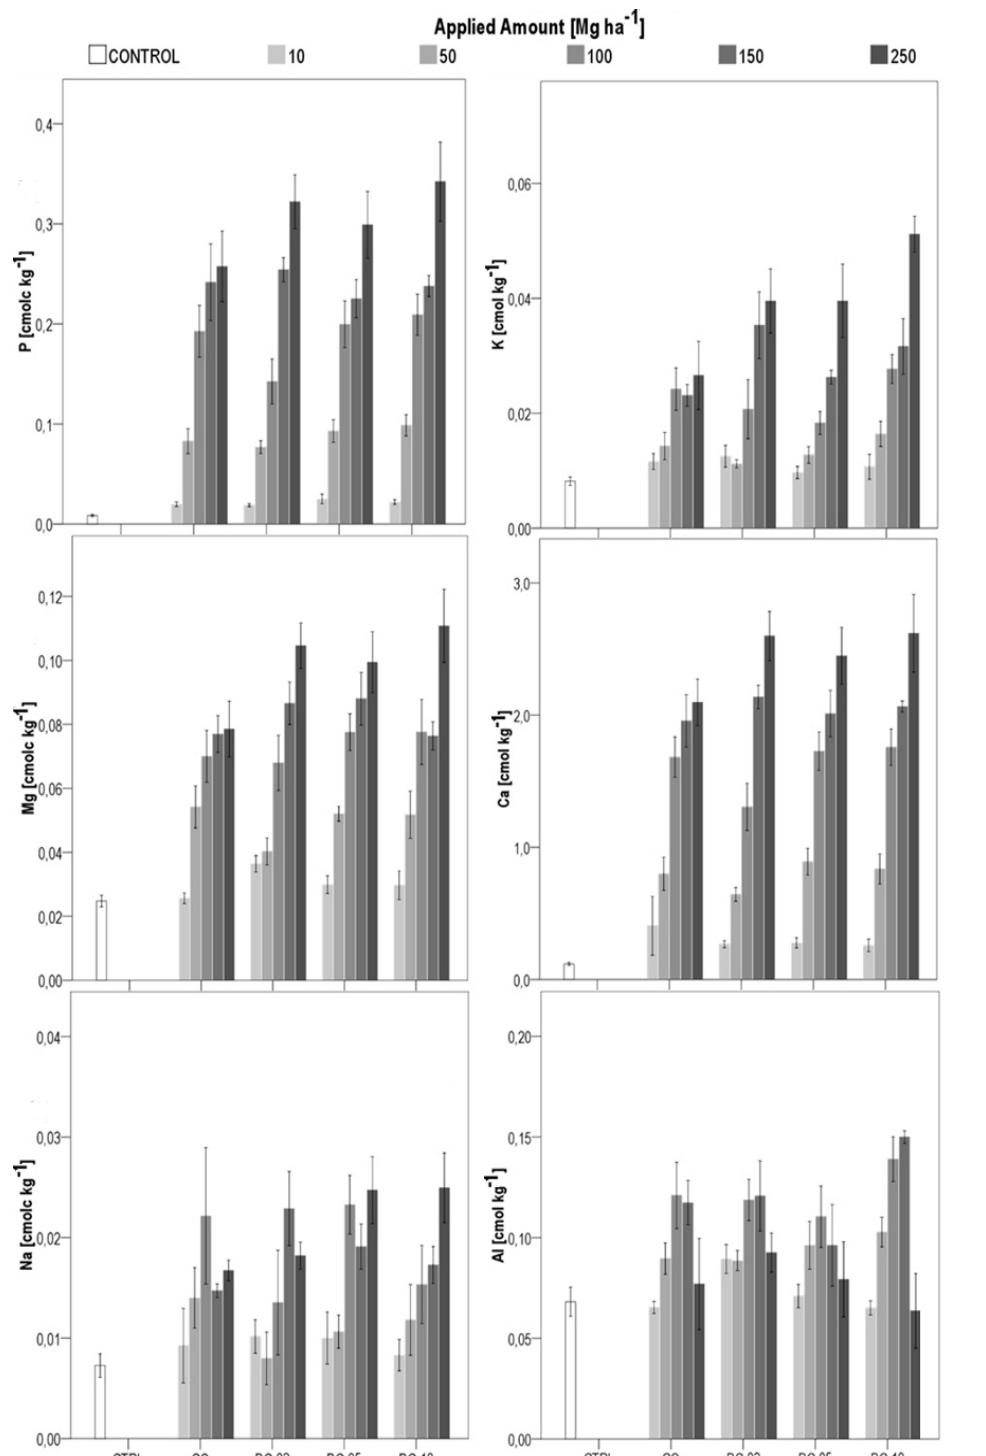
Figure 6. Plant-available nutrients and Aluminum (in cmolc kg −1 soil) on sandy substrate depicted for five treatments (CO = pure compost, BC-03 = compost with 3 kg Mg −1 w / w biochar, BC-05 = compost with 5 kg Mg −1 w / w biochar, BC-10 = compost with 10 kg Mg −1 w / w biochar) in five application amounts (10, 50, 100, 150, 250 Mg ha −1 ) versus control (CTRL = pure sandy substrate) ( n =